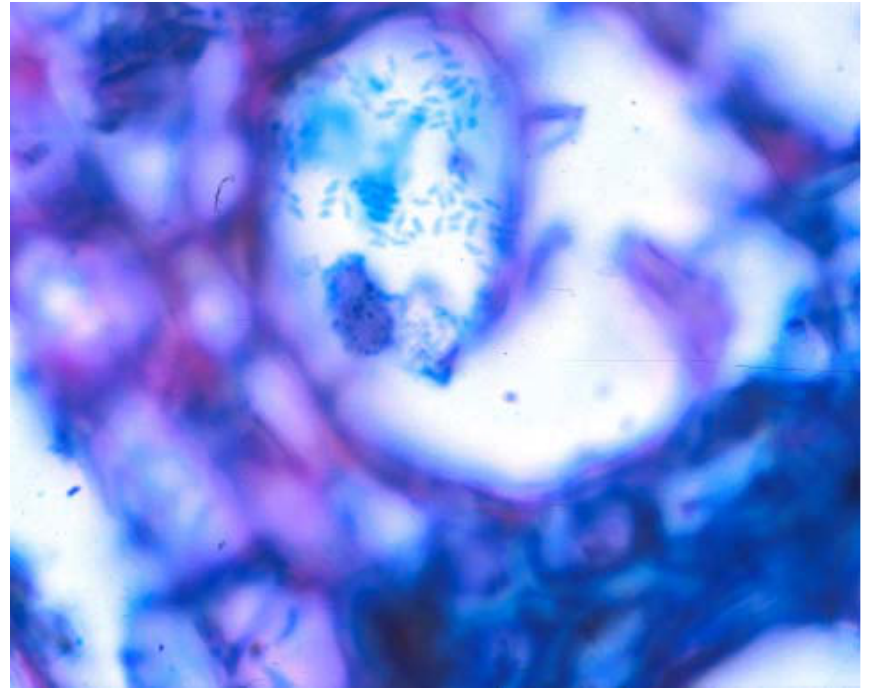
Fig. 6. Cross-section of stem showing fungal invasion in the secondary xylem. Note spores of Phaeoacremonium aleophilum in the metaxylem. (cid:1)